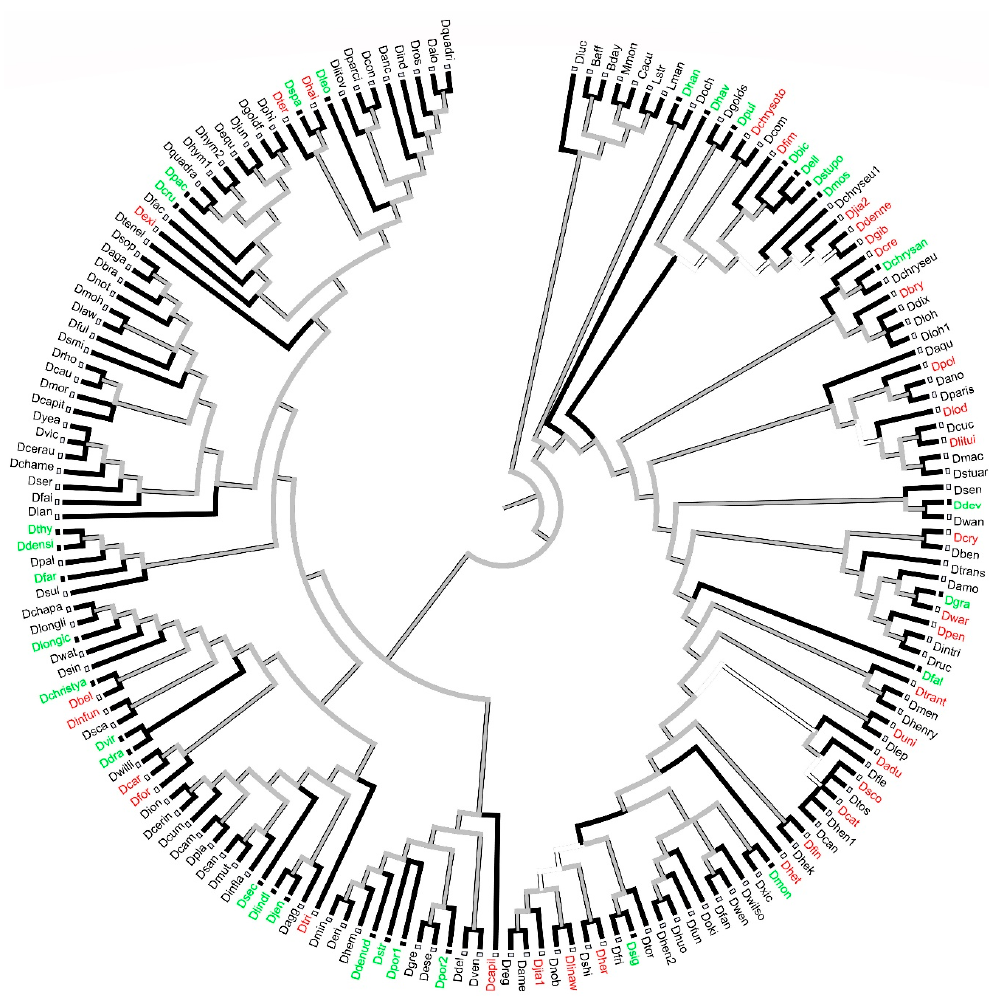
Figure 10. Parsimony inference of the mating system evolution of Dendrobium. Red words: self- compatibility; green words: self-incompatibility. Lman, Bday, Baff, Lstr, Cacu, Mmon, and Dluc were used as outgroups. Baff: Bulbophyllum affine ; Bday: Bulbophyllum dayanum ; Cacu: Crepidium acuminatum ; Dadu: Dendrobium aduncum ; Daga: Dendrobium agathodaemonis ; Dagg: Dendrobium aggregatum ; Dalo: Dendrobium aloifolium ; Dame: Dendrobium amethystoglossum ; Damo: Dendrobium amoenum ; Danc: Dendrobium anceps ; Dano: Dendrobium anosmum ; Daqu: Dendrobium aqueum ; Dbel: Dendrobium bellatulum ; Dben: Dendrobium bensoniae ; Dbic: Dendrobium bicameratum ; Dbra: Dendrobium bracteosum ; Dbry: Dendrobium brymerianum ; Dcam: Dendrobium camptocentrum ; Dcan: Dendrobium candidum ; Dcapil: Dendrobium capillipes ; Dcapit: Dendrobium capituliflorum ; Dcar: Dendrobium cariniferum ; Dcat: Dendrobium catenatum ; Dcau: Dendrobium cauliculimentum ; Dcerin: Dendrobium cerinum ; Dcerau: Dendrobium ceraula ; Dchapa: Dendrobium chapaense ; Dchame: Dendrobium chameleon ; Dchrysan: Dendrobium chrysanthum ; Dchryseu: Dendrobium chryseum ; Dchrysoto: Dendrobium chrysotoxum ; Dchristya: Dendrobium christyanum ; Dcom: Dendrobium compactum ; Dcon: Dendrobium confusum ; Dcre: Dendrobium crepidatum ; Dcru: Dendrobium crumenatum ; Dcry: Dendrobium crystallinum ; Dcuc: Dendrobium cucullatum ; Dcum: Dendrobium cumulatum ; Ddel: Dendrobium delacourii ; Ddenne: Dendrobium denneanum ; Ddenud: Dendrobium denudans ; Ddensi: Dendrobium densiflorum ; Ddev: Dendrobium devonianum ; Ddix: Dendrobium dixanthum ; Ddra: Dendrobium draconis ; Dell: Dendrobium ellipsophyllum ; Dequ: Dendrobium equitans ; Deri: Dendrobium eriiflorum ; Dese: Dendrobium eserre ; Dexi: Dendrobium exile ; Dfac: Dendrobium faciferum ; Dfai: Dendrobium fairchildae ; Dfal: Dendrobium falconeri ; Dfan: Dendrobium fanjingshanense ; Dfar: Dendrobium farmer ; Dfim: Dendrobium fimbriatum ; Dfin: Dendrobium findlayanum ; Dfle: Dendrobium flexicaule ; Dfor: Dendrobium formosum ; Dfri: Dendrobium friedricksianum ; Dful: Dendrobium fulgidum ; Dfun: Dendrobium funiushanense ; Dgib: Dendrobium gibsonii